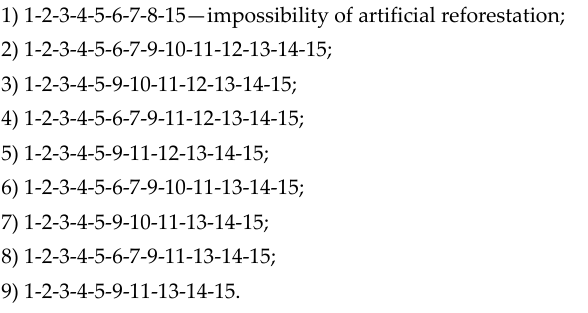
Figure 2. Possible sets of technological operations for the classical FLR algorithm.